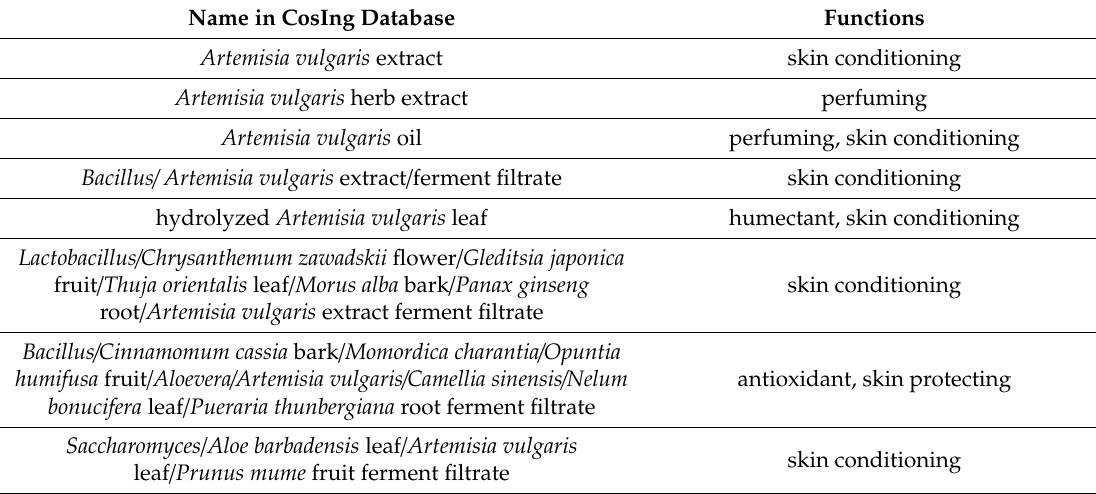
Table 7. Applications of A. vulgaris in cosmetology as recommended by the CosIng